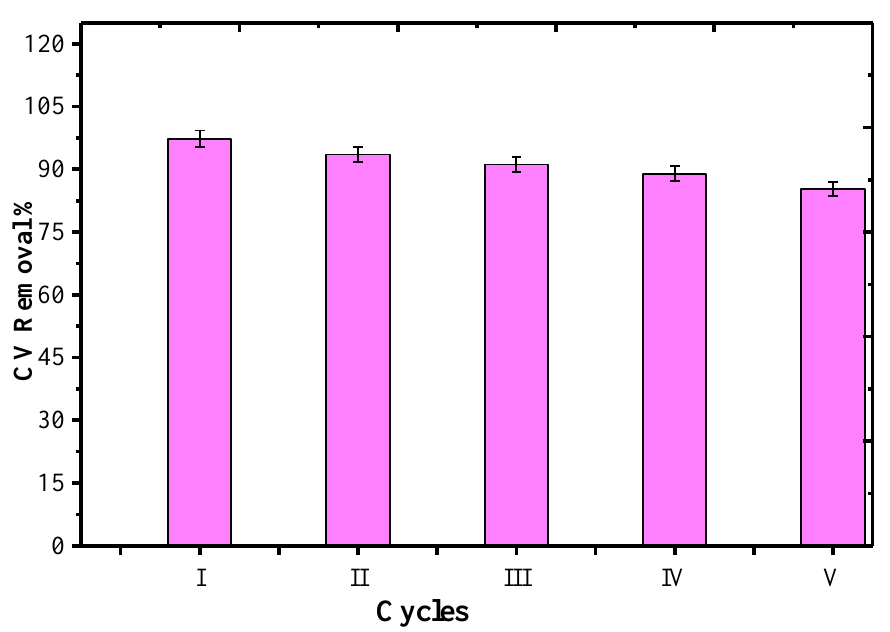
Figure 10. The regeneration cycles of AS-g-PAni@MS bonded CV, using 0.1 M HNO 3 solution.